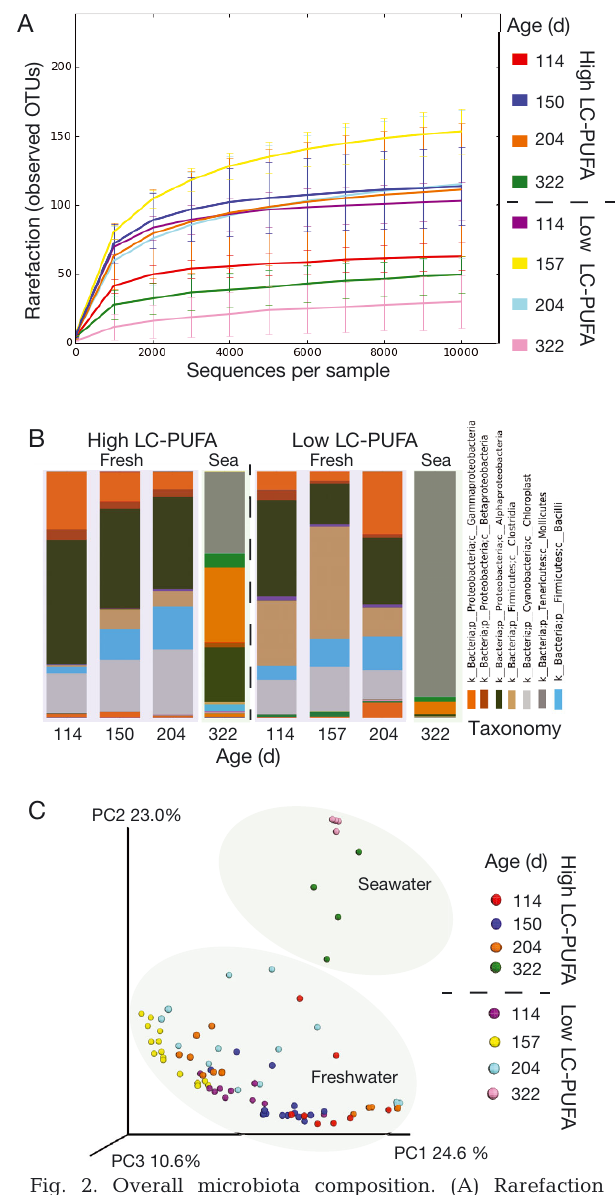
Fig. 2. Overall microbiota composition. (A) Rarefaction analyses, (B) taxonomic composition, and (C) beta diversity, as visualized by Bray-Curtis principal coordinate analysis. Age and diet indicated by a color code. Graphics were generated using the QIIME pipeline (Caporaso et al. 2010). LC-PUFA = long-chain polyunsaturated fatty